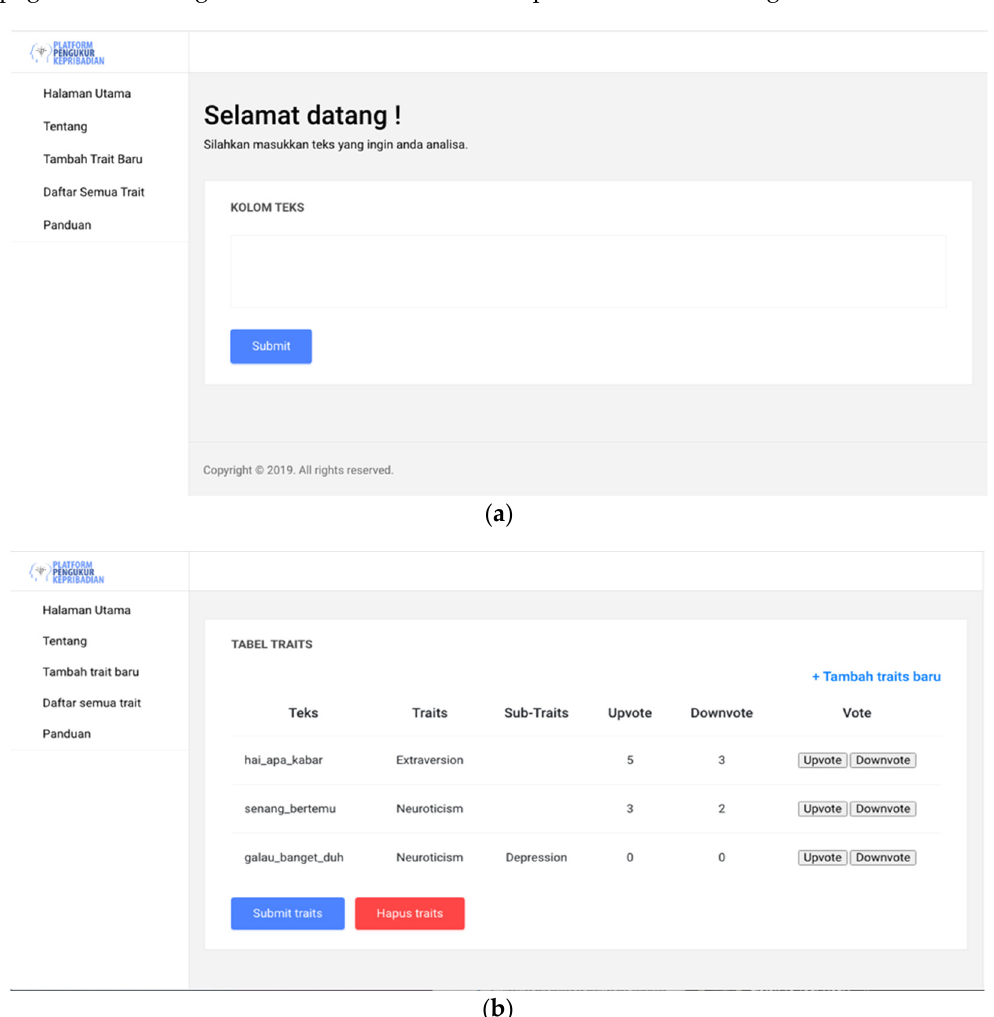
Figure 6. ( a ) The platform interface, ( b ) The interface for voting mechanism in crowdsourcing.